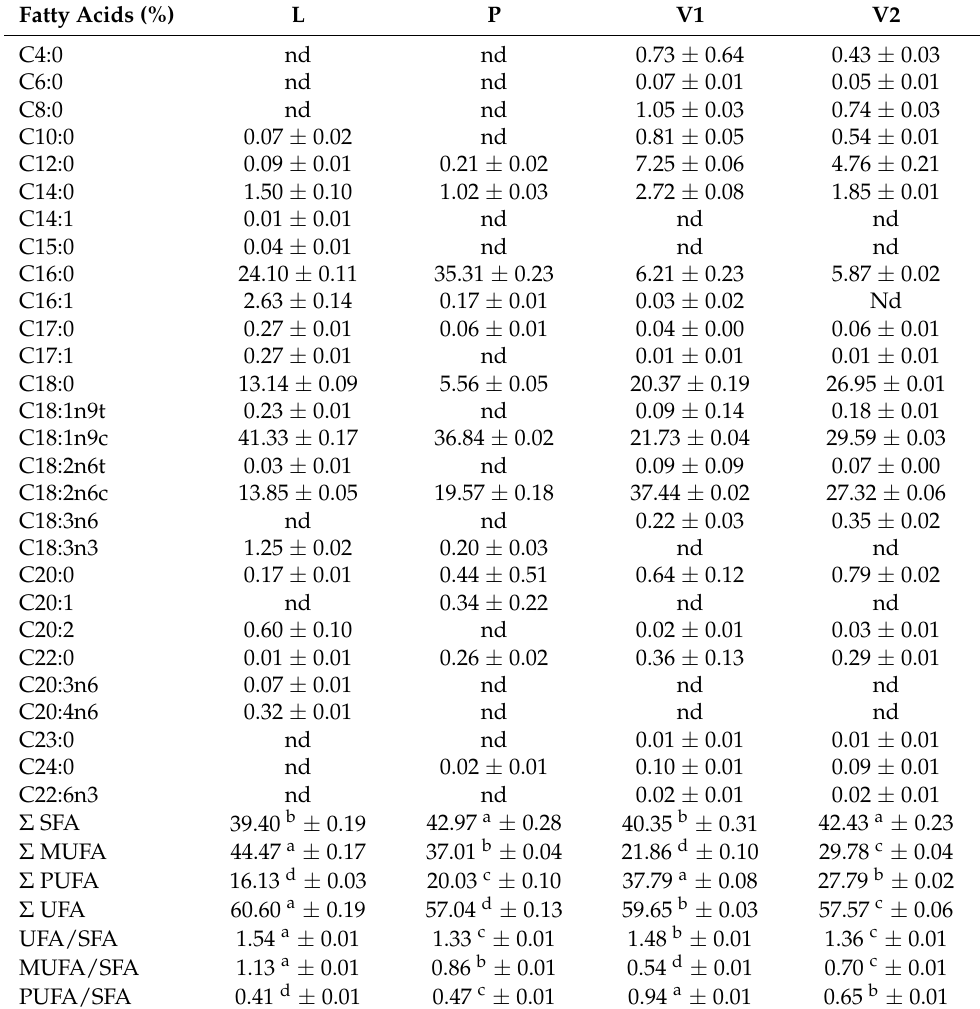
Table 2. Fatty acid compositions (mean ± SD) of the fat blends L, P, V1, and V2 (for identification of the samples see Table